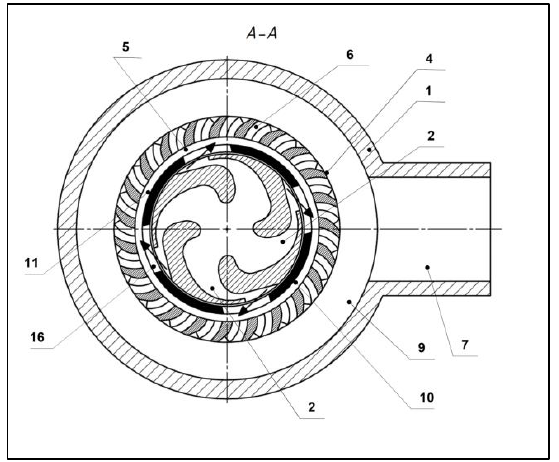
Figure 4. Schematic of the mesh turbine, A−A cross-section in the rotor braking and stopping mode.